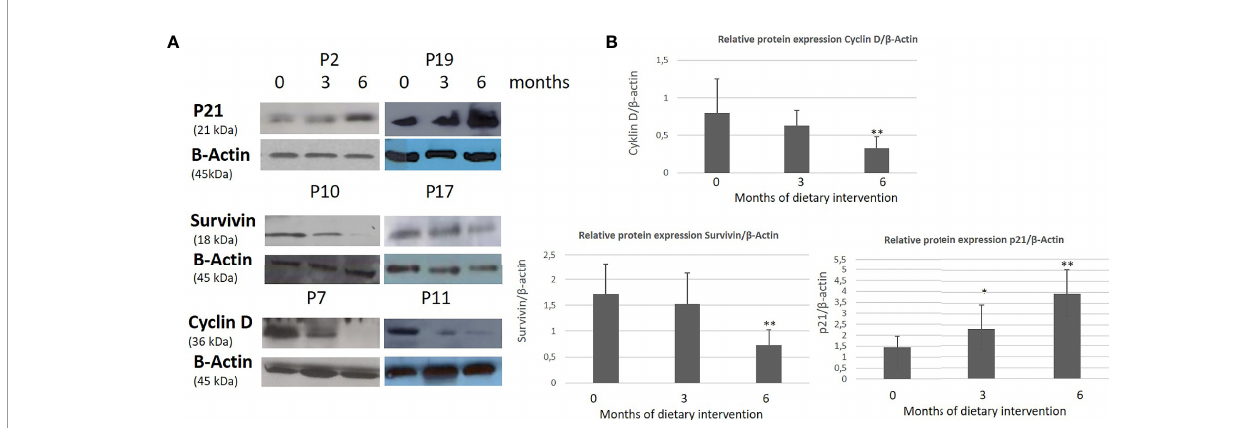
FIGURE 6 | Effect of High OC/OL - EVOO on cyclin D, Survivin and p21 protein expression in PMBC cells of patients with CLL during DI2. The protein expression level was measured by Western blot analysis at baseline, at 3 and 6 months after dietary intervention in equal amount of cell lysate (40 lg/lane) from isolated PMBC cells of each participant. Cell lysates was subjected to electrophoresis and analyzed by Western blot. (A) Representative blots shown for each studied protein for selected patients (P2, 7, 10, 11, 17, 19). (B) The densitometry measurements are depicted in histograms. The data in the histograms are the mean ± SD of 22 different experiment subjects. The protein expression levels are normalized according to the measurement of b -actin in a semi quantitative analysis. Quanti fi cation of relative protein expression of the Western signals (complexed protein bands) was performed manually using the image analysis program, Image-J (IE 6.0, Microsoft Java). Data were compared using the unpaired two-tailed t-test. Signi fi cant difference between the time points of the dietary intervention at p <0.05 (*0 – 3, **3 – 6 and 0 – 6) is